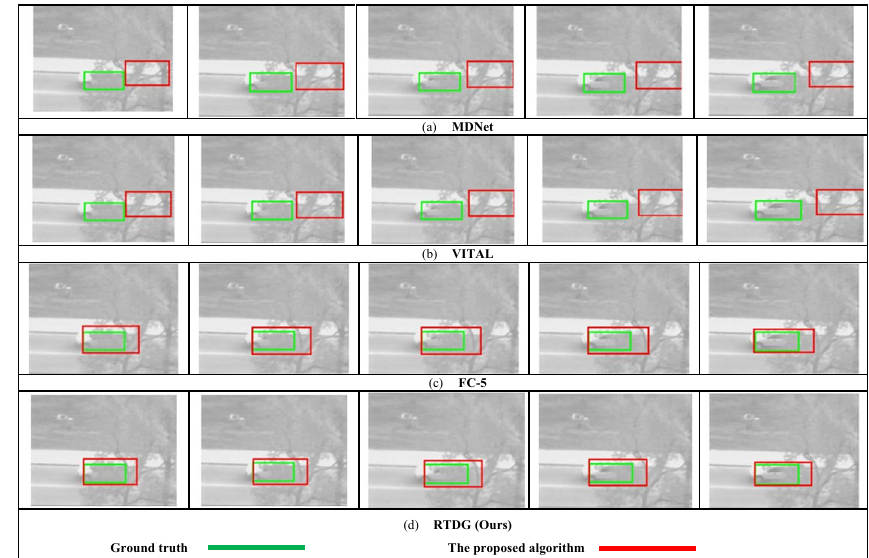
Fig. 7 Tracking results of the compared trackers on the ’Suv’ video (frames: 562 to 566)